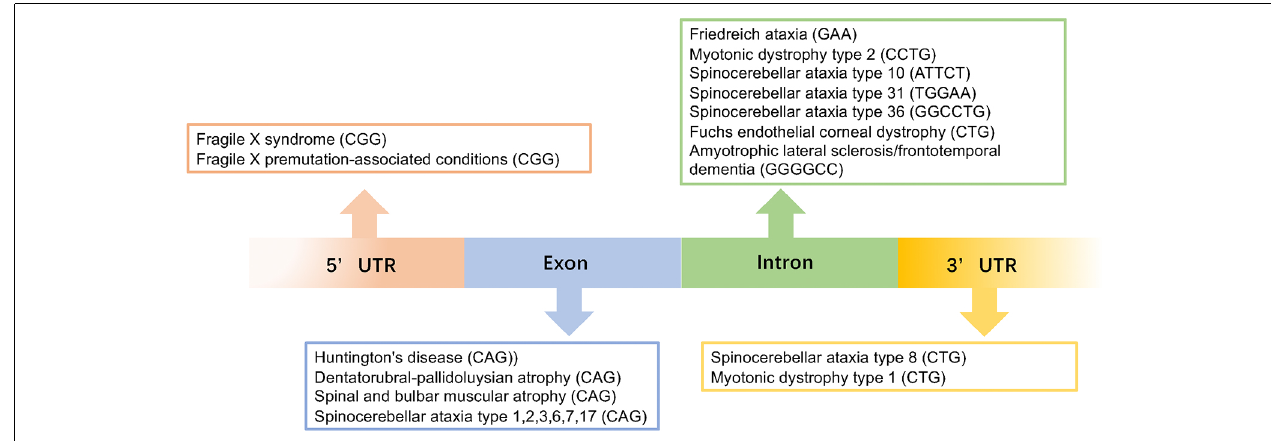
FIGURE 1 | This image gives an overview of the repeat expansions seen in different diseases with the gene locations for each